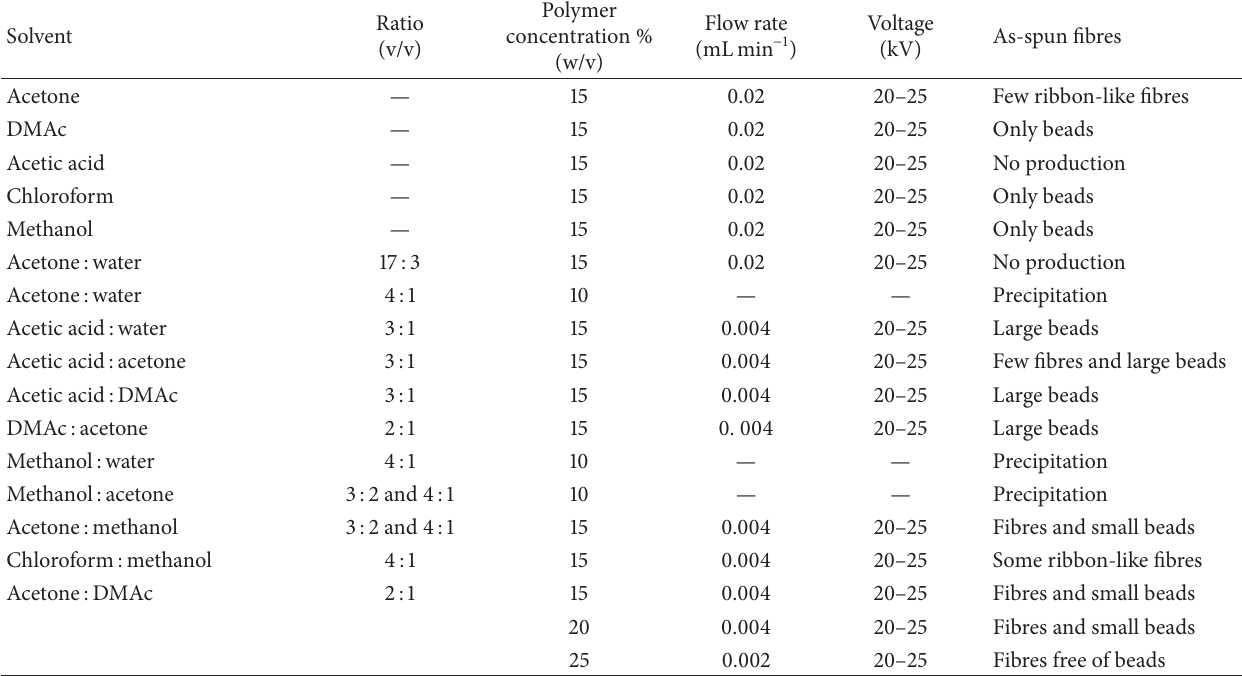
Table 1: Experimental conditions: combinations of solvent systems, polymer concentration, and spinning solution flow rate and voltage.